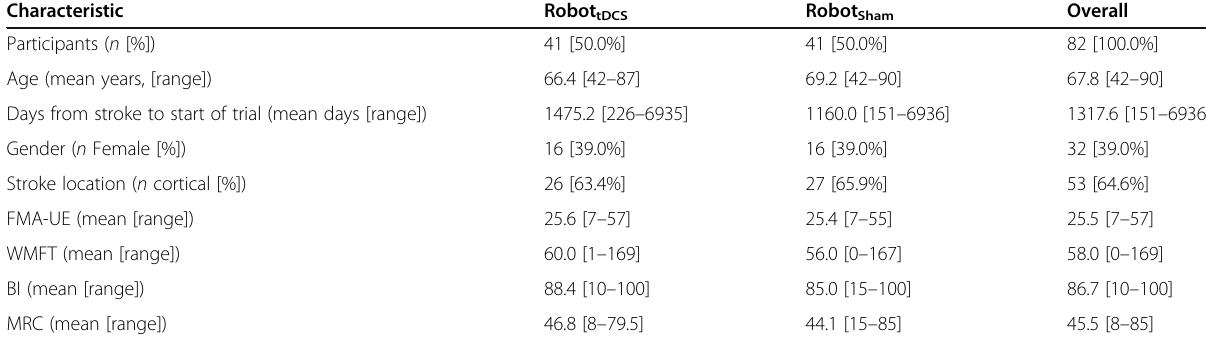
Table 1 Participant characteristics and clinical admission results of Robot tDCS, Robot Sham , and the combined groups (overall)